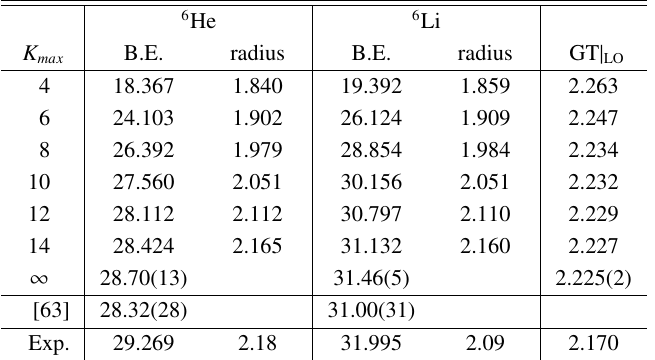
Table 4. The JISP16 NN interaction 6 He, 6 Li binding energies, rms matter radii, and the leading order GT matrix element as a function of K max .